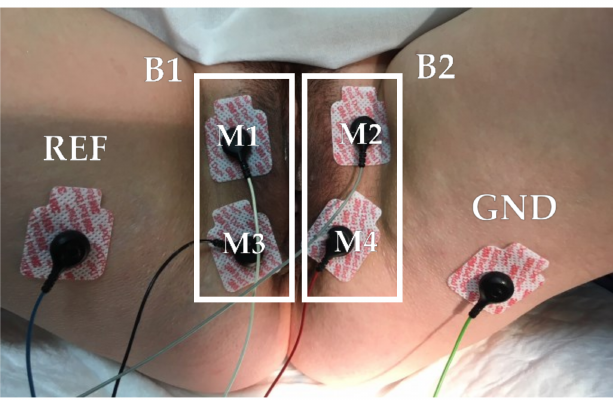
Figure 1. Electrodes location for the surface electromyogram (sEMG) signal